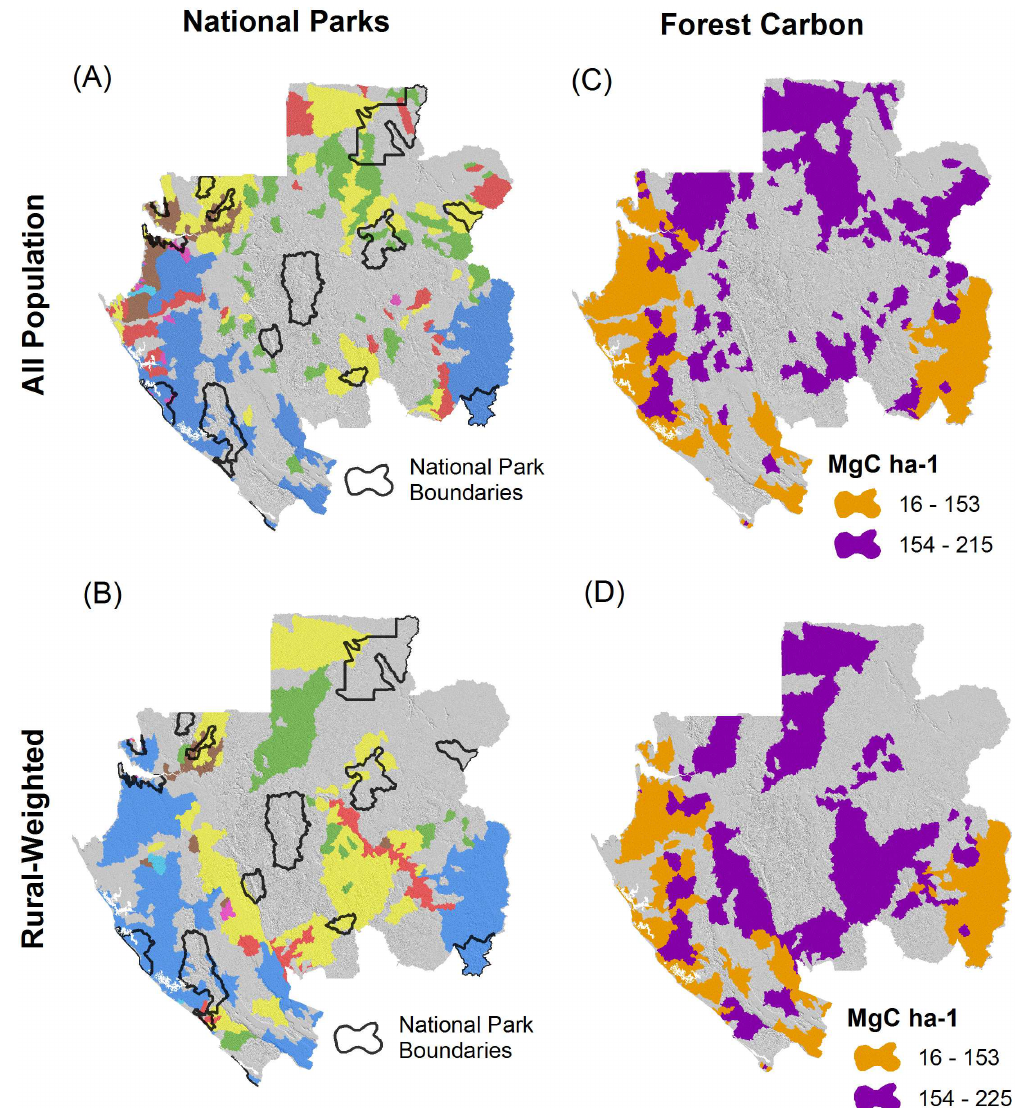
Fig 6. Overlap of hydrologic ecosystem servicespriority areaswith other indicators of conservation value. Overlap with national parks (shown in black outline)for (A) “all population”and (B) “rural-weighted” scenarios.All other colors representportfolio sub-watersheds as describedin Fig 5. Overlap with forest carbon stocks belowor equal to (orangecolor) or above(purplecolor) the averagesub-watershed total carbon stock across the country (154 MgC ha -1 ) for (C) “all population” and (D) “rural-weighted”